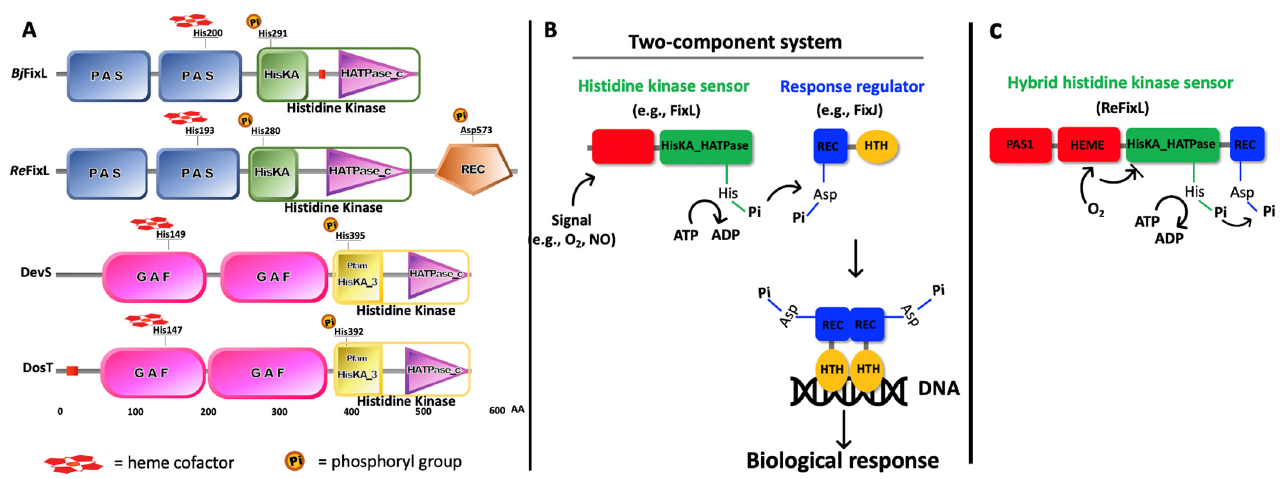
Figure 3. ( A ) Domain organization of FixL and DevS/DosT (heme as a red small structure, phosphorylation indicated by Pi; heme proximal ligand and phosphorylatable residues are shown) composed of the PAS and GAF domains along with the histidine kinase domain constituted of the HisKA and HATase_c subdomains. Hybrid FixL ( Re FixL) presents an additional REC domain (receiver domain) usually found at the N-terminal region of the response regulator proteins. ( B ) Cartoon of the functioning of common two-component systems, where a histidine kinase sensor upon the appropriated signal becomes active, autophosphorylating a histidine residue; then, a phosphoryl group is transferred to the response regulator protein. This later becomes active upon phosphorylation and usually functions as a transcriptional factor triggering a biological response. ( C ) Autophosphorylation of the hybrid Re FixL, where O 2 blocks histidine kinase and phosphotransferase activities. His = histidine residue, Asp = aspartate residue, AA = amino